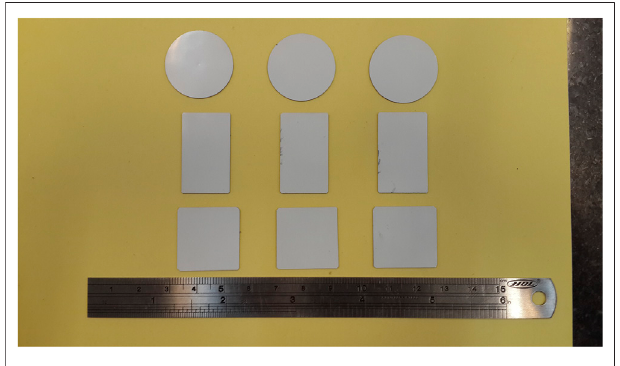
FIGURE 3 | Small half-cells with different shapes before sintering